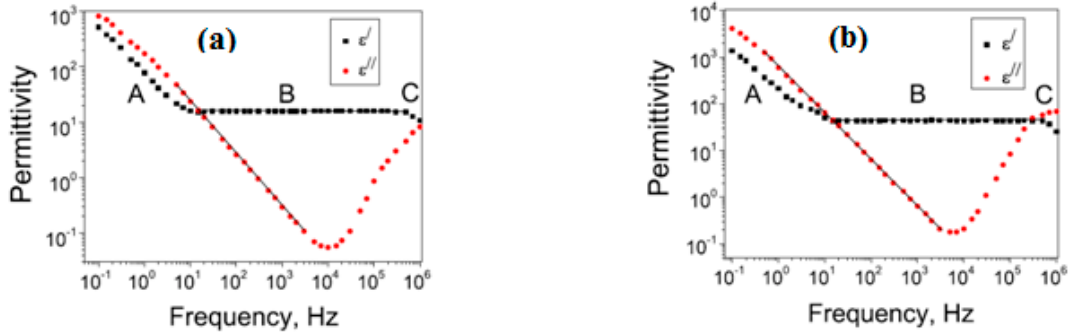
Figure 1. Variations of real ( ε ') and imaginary ( ε '') parts of complex dielectric constant at 20 °C for ( a ) pristine and ( b ) diamond nanoparticles (NPs) (2 wt%) dispersed nematic E7 [41].